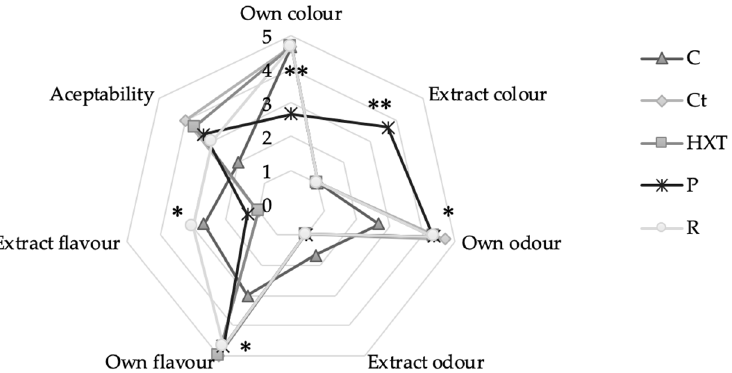
Figure 5. Sensory scores for fish patties stored in aerobic conditions for up to 14 days at 4 °C under simulated retail display conditions. Control sample (C); sample enriched in citrus (Ct); sample enriched in hydroxytyrosol (HXT); sample enriched in pomegranate (P); sample enriched in rosemary (R). * Significant differences p < 0.05. ** Significant differences p < 0.01.